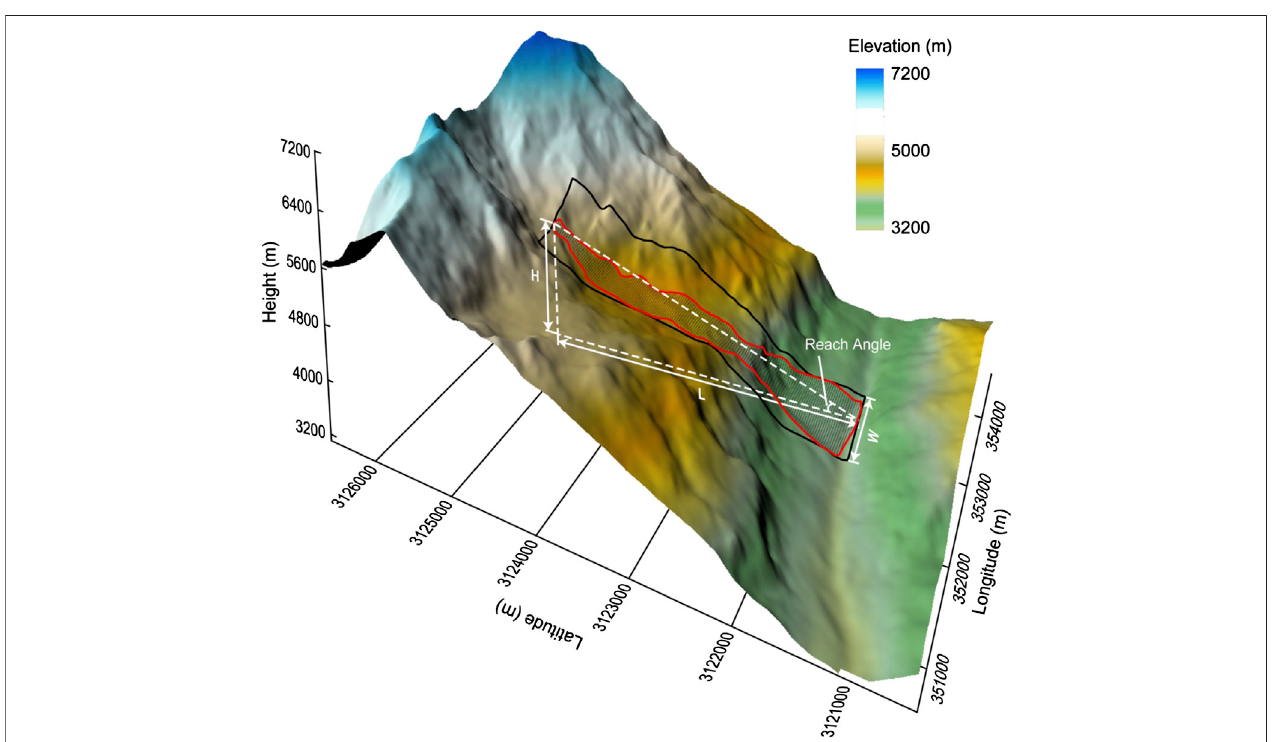
FIGURE 3 | Geometrical parameters illustrated on the Langtang